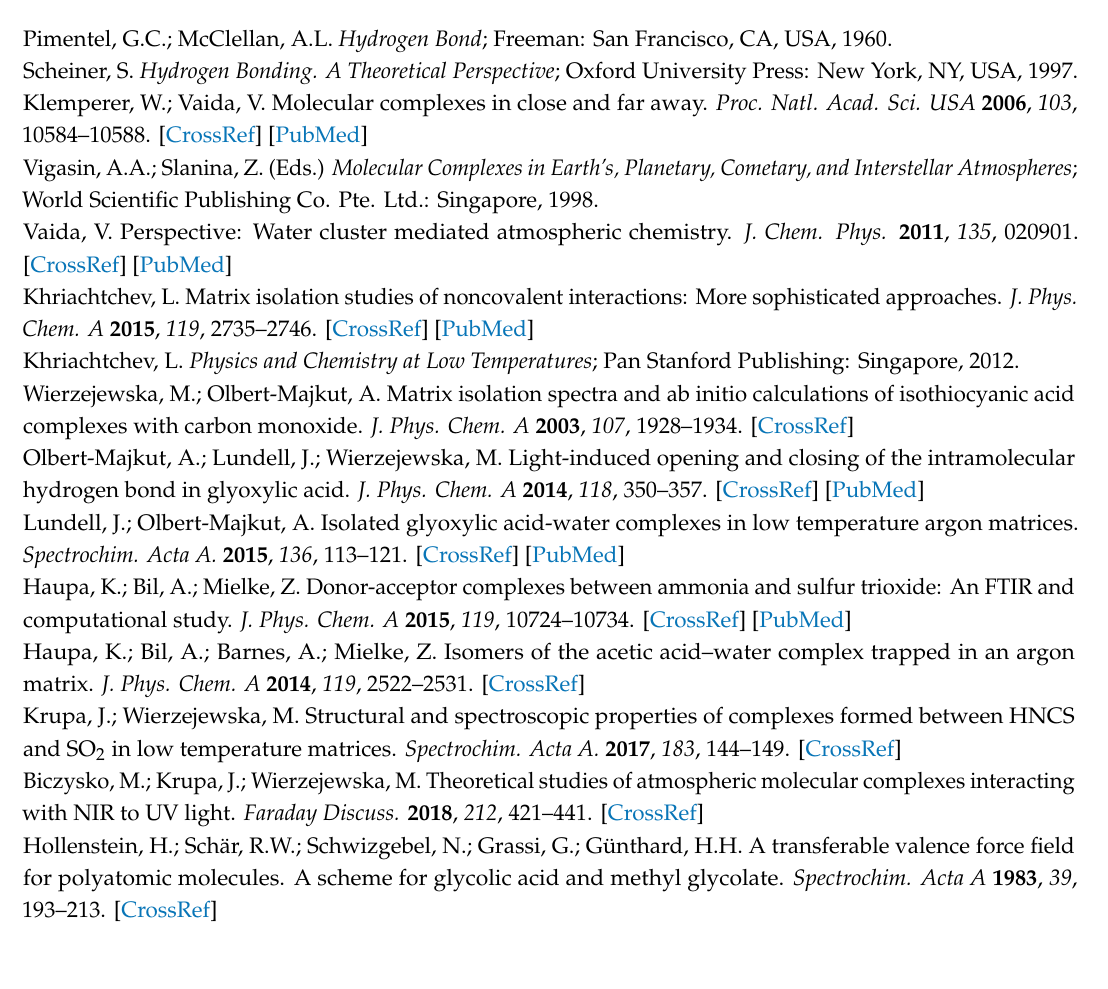
Supplementary Materials: The following are available online, Figure S1. Plot showing changes of the energy, ν C = O, δ OH wavenumbers calculated for each point of the relaxed potential energy scan for the bending movement of the N 2 molecule in SSC1 complex calculated at the B3LYPD3 and MP2 levels with 6-311 ++ G(2d,2p) basis set versus deviation of the C4O6N10 angle. Table S1 . Cartesian coordinates of N 2 , GA monomers and GA ··· N 2 complexes of the 1:1 stoichiometry calculated at MP2 / 6-311 ++ G(2d,2p) level. Author Contributions: Conceptualization: M.W. and J.L.; methodology: M.W., J.L. and J.M.E.A.; formal